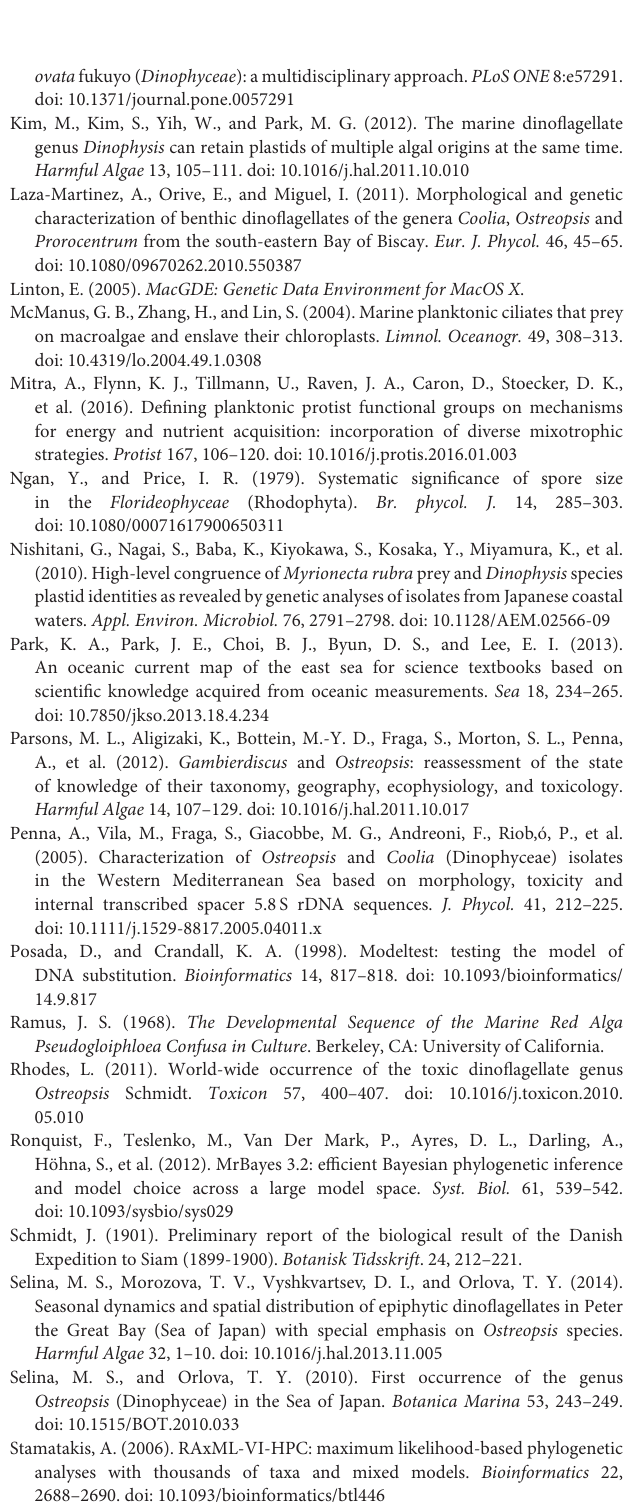
are indicated at nodes. Double slash marks indicate shrink nodes length (70%). Table S1 | Details of dominant macroalgal species collected at each sampling time and site in this study. R, red algae; B, brown algae; G, green